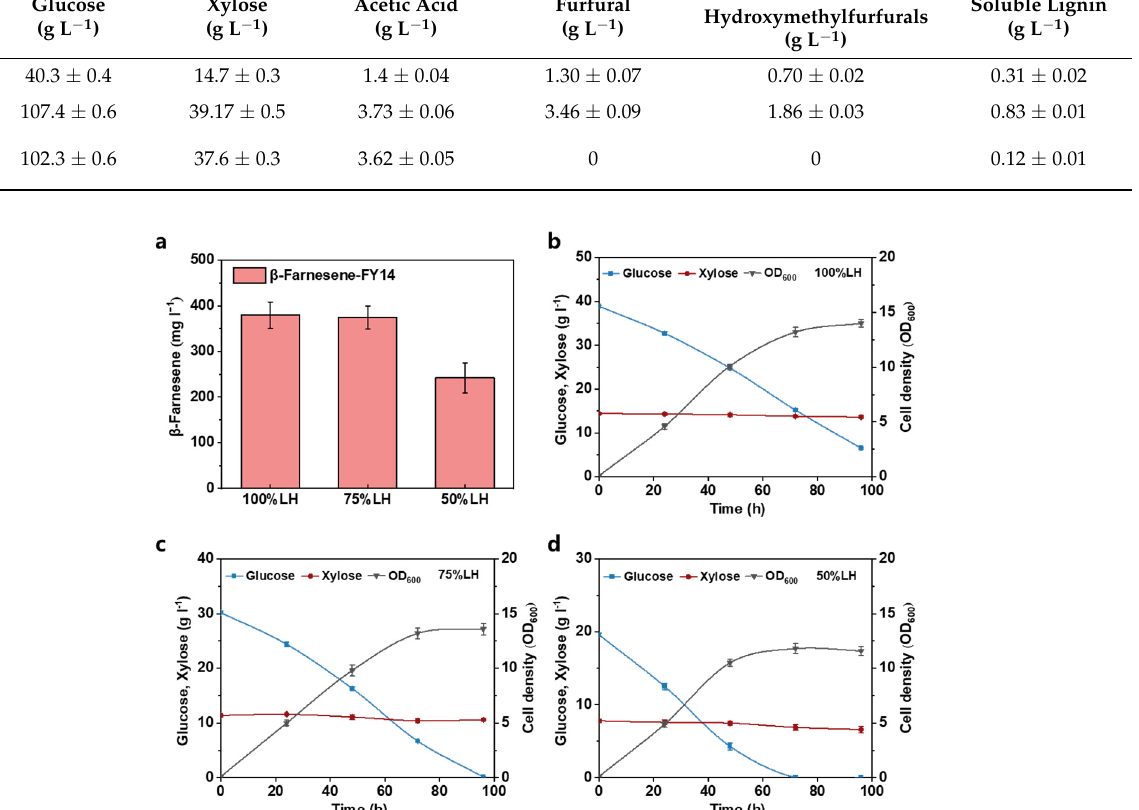
Figure 6. Fermentation results of strain FY14. ( a ) Titer of β -farnesene in 100%, 75%, and 50% LH media. ( b – d ) Cell density, glucose, and xylose consumption curves for 100%, 75%, and 50% LH media, respectively. β -Farnesene was detected at 96 h of fermentation. Data are represented as mean ± standard deviation (n = 3).